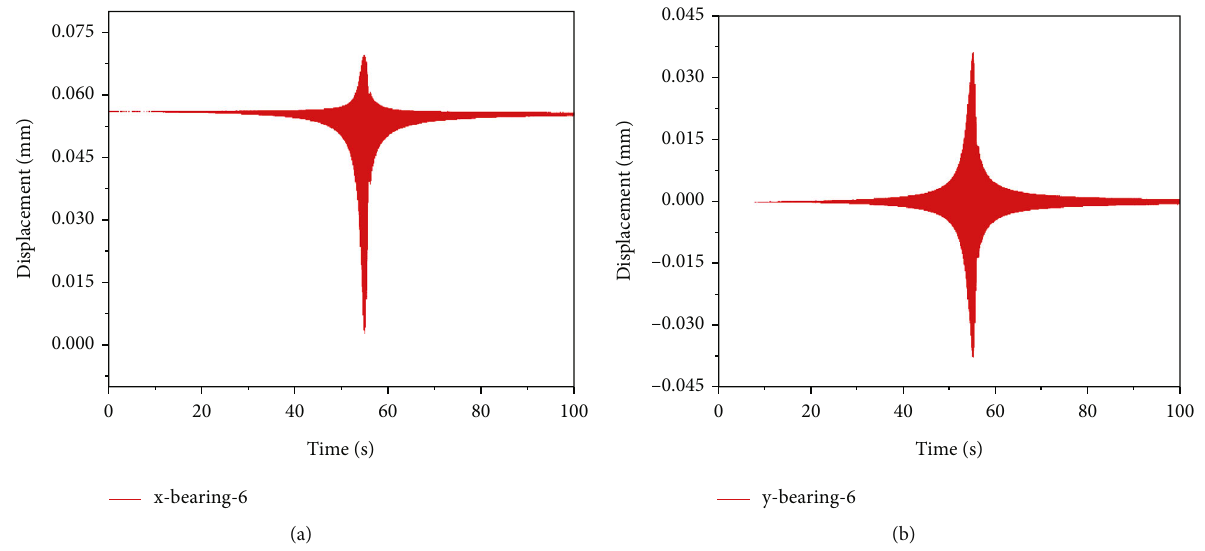
Figure 18: Time-domain response diagram of the nodes at the rear bearing in case 6. (a) Response in the x -axis direction. (b) Response in the y -axis direction.